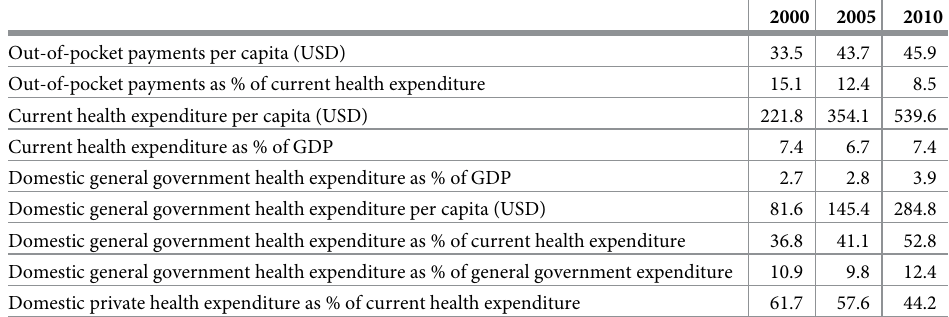
Table 4. Macroeconomic data on health